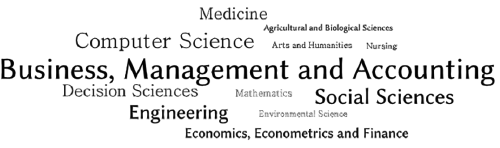
Figure 2. The most popular areas of publication classification for the SERVQUAL model in the Scopus database (source: own elaboration based on data from the Scopus